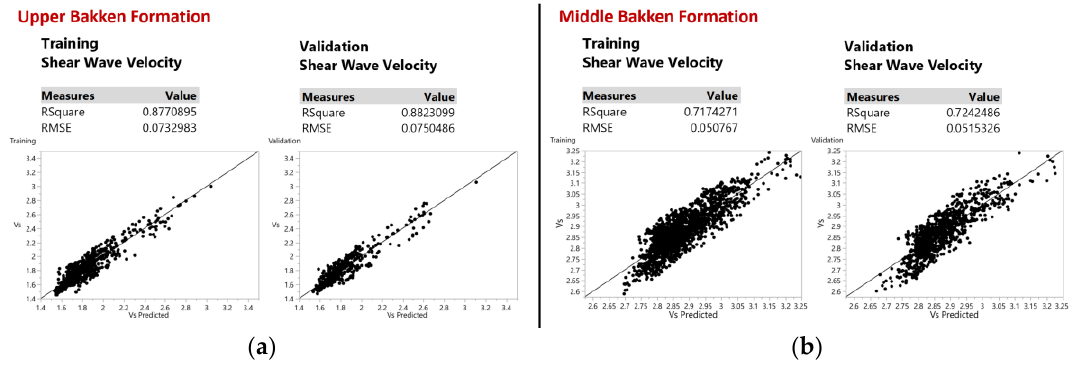
Figure 5. Prediction of shear wave velocity linearly with its training and validation set for ( a ) the Upper Bakken Formation ( b ) Middle Bakken Formation.